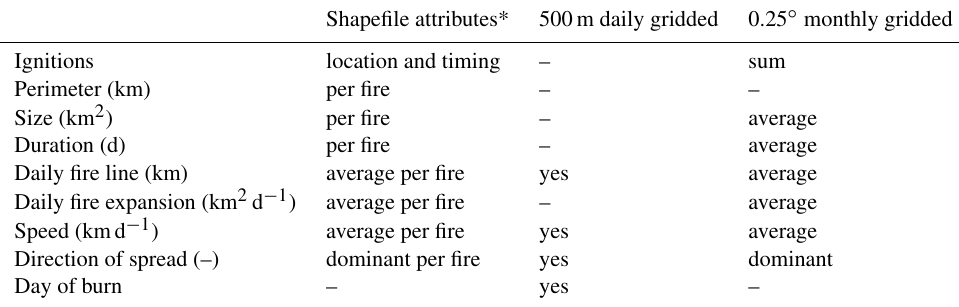
Table A1. Overview of the Global Fire Atlas data layers. The shapefiles of ignition locations (point) and fire perimeters (polygon) contain attribute tables with summary information for each individual fire, while the underlying 500m gridded layers reflect the day-to-day behavior of the individual fires. In addition, we provide aggregated monthly layers at a 0.25 ◦ resolution for regional and global analyses.